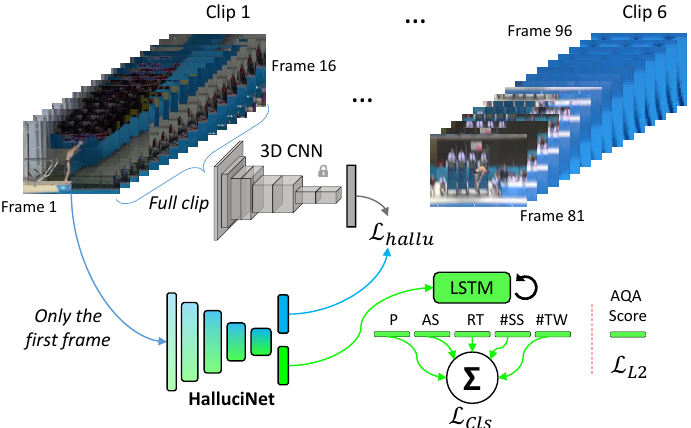
Figure 3. Detailed action recognition and action quality assessment